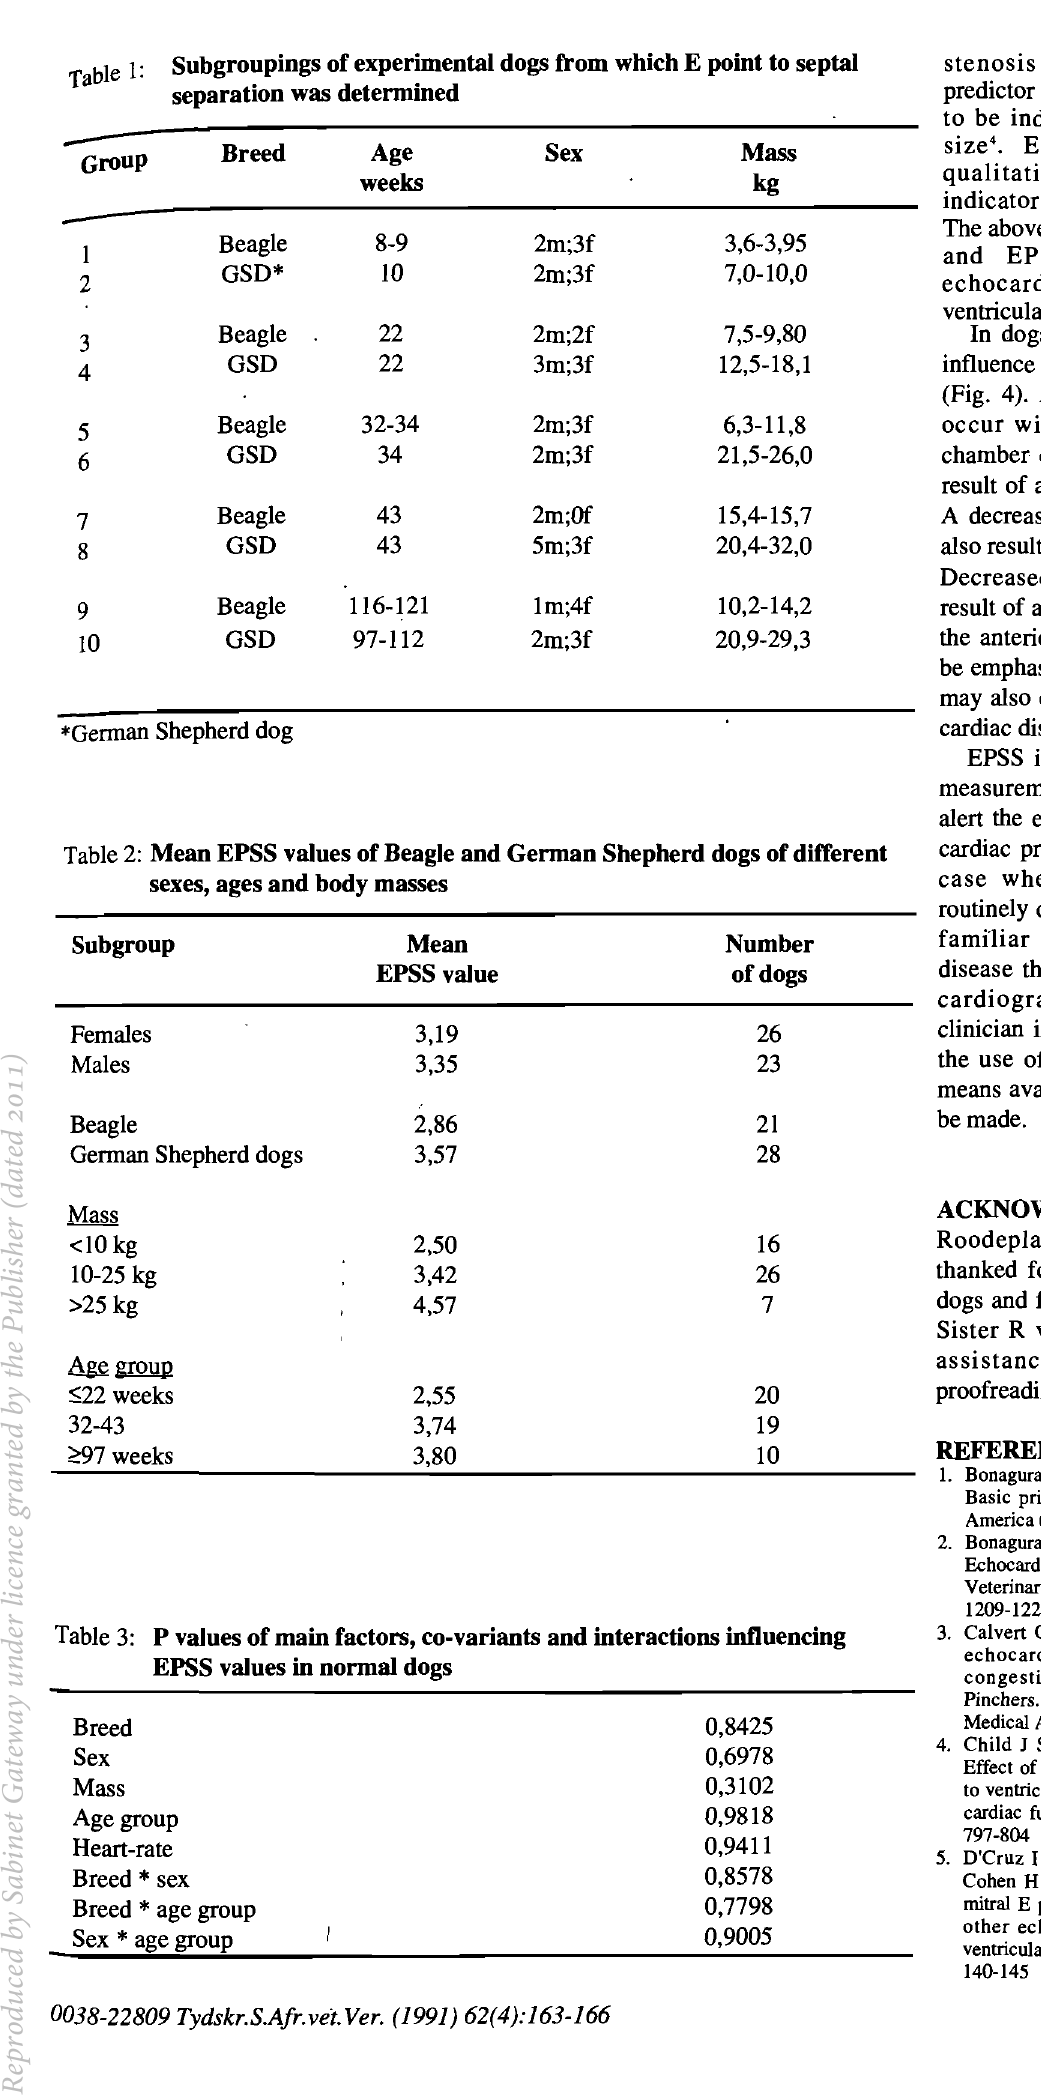
Table 3: P values of main factors, co-variants and interactions influencing EPSS values in normal dogs Breed Sex Mass Age group Heart-rate Breed * sex Breed * age group Sex * age